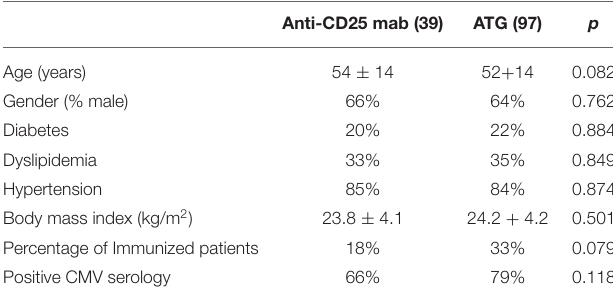
TABLE 5 | Clinical characteristics of the replication